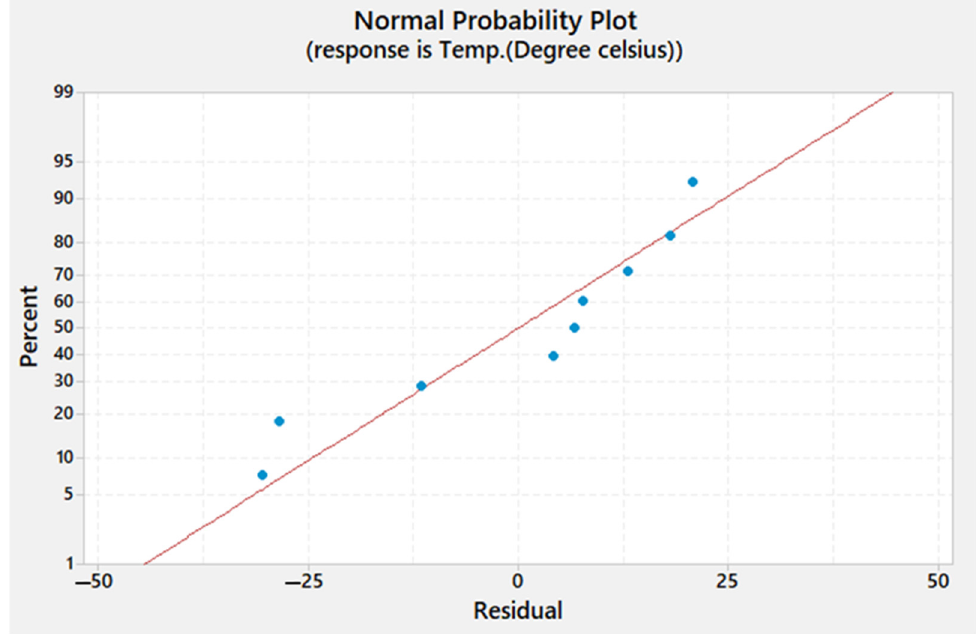
Figure 13. Normal probability plot of the residuals for the temperature of the weld zone.